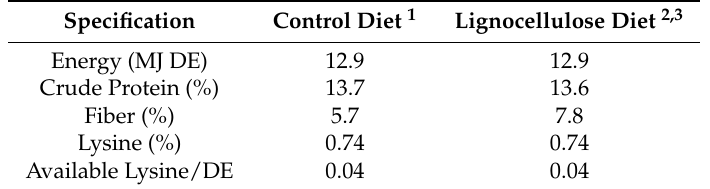
Table 1. Energy, crude protein, fiber, and lysine levels in the standard and lignocellulose-enhanced